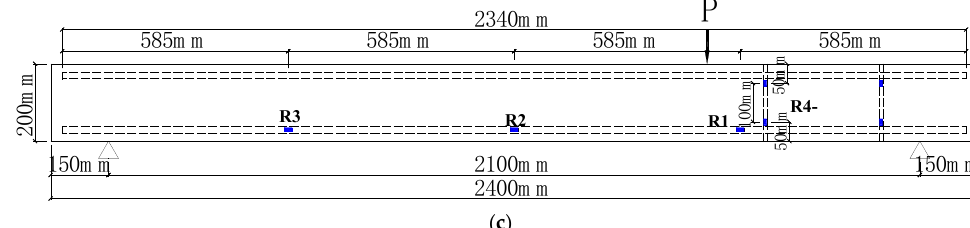
Figure 8. Measurement set-up in this test: ( a ) Displacement transducers (T1-T6: displacement transducers); ( b ) Strain gauges for concrete slabs; ( c ) Strain gauges for embedded bars and steel reinforcement (R1-R6: electrical resistant strain (ERS)).